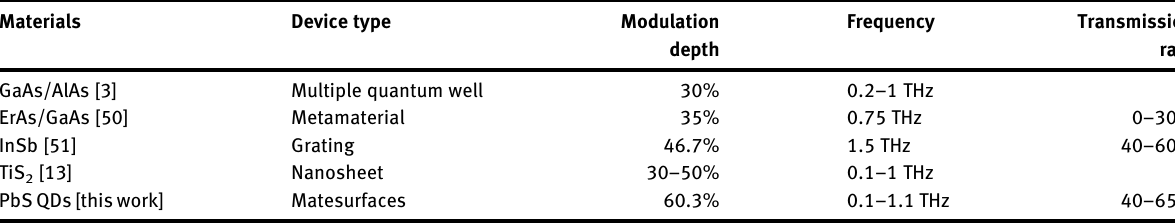
Table  : Comparison of the optically controlled THz modulators based on different material systems.